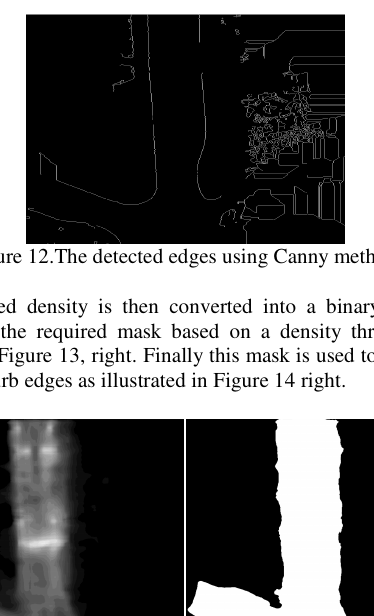
Figure 9. Segmentation results (top down view). Left: Ground segment-phase three. Right: Ground segment-phase four.